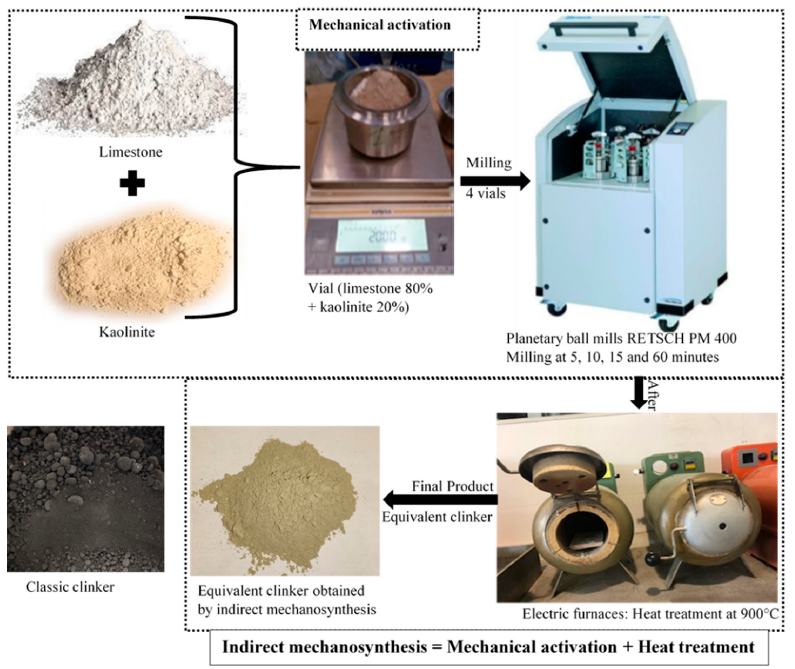
Figure 1. Representative schematic of indirect mechanosynthesis.